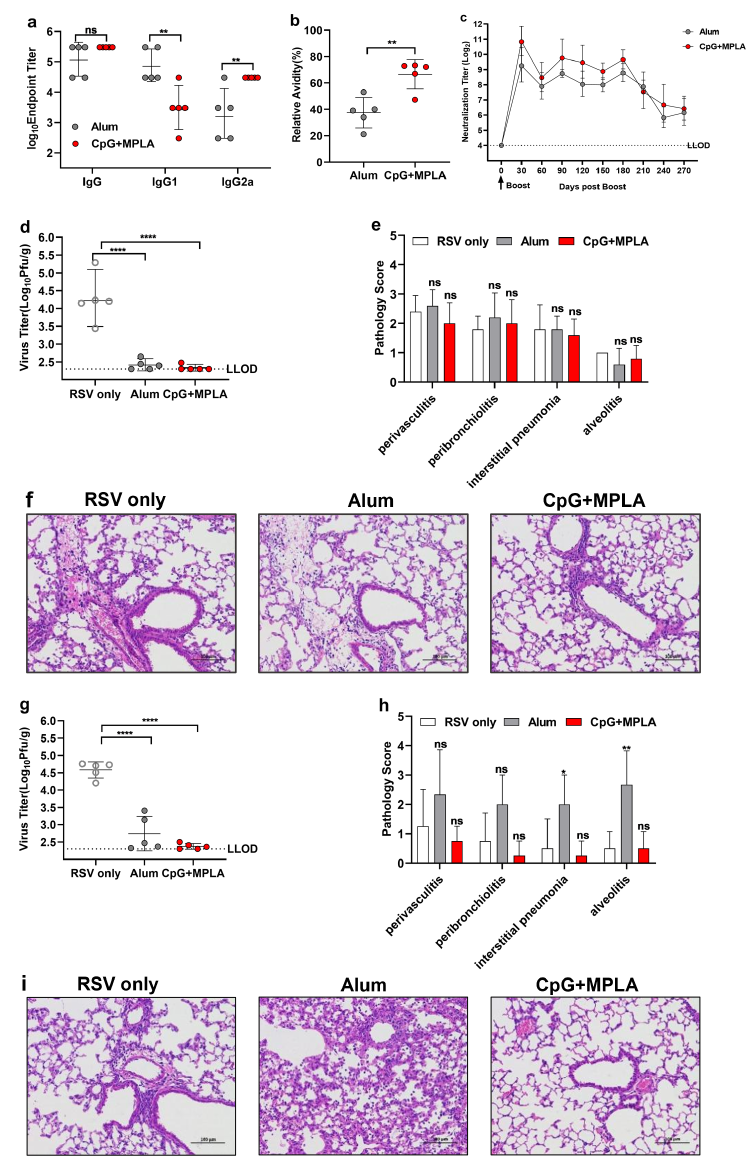
Figure 8. Opti-FI-RSV plus CpG + MPLA adjuvant protects mice from RSV challenge without inducing ERD when neutralizing antibody titers decrease. Female BALB/c mice (n = 5 per group) were injected intramuscularly with opti-FI-RSV combined with a Th2-biasing adjuvant (Alum) or a Th1-biasing adjuvant combination (CpG + MPLA) in a prime-boost regimen at week 0 and week 3. Animals were challenged with the RSV A2 strain intranasally at a titer of 2 × 10 6 PFU on day 49 and day 273. ( a , b ) Pre-F-specific IgG, isotype IgG1 and IgG2a serum antibody titers were determined at 2 weeks after boosting, and IgG avidity against pre-F after 7 M urea wash was determined at the same time point. ( c ) Serum neutralizing antibody titers were measured using RSV A2 with the indicated schedule. ( d , e ) Lung virus titers and histopathology scores were evaluated at day 5 after the first challenge ( d , e ) and second challenge ( g , h ). Representative H & E staining images are shown in ( f , i ). ( a – d , g ) The symbols indicate individual mice, the bars/lines indicate the geometric mean ± geometric SD, and the dotted lines indicate the lower limit of detection and the protective threshold. ( g , h ) The bars/lines indicate the mean ± SD. The data were analyzed by ( a , b ) t test, ( d , g ) one-way ANOVA followed by Tukey’s multiple comparisons post hoc test and ( e , h ) Kruskal-Wallis test (nonparametric) to analyze the differences between vaccination groups. The adjusted p values are shown by asterisks (ns = not significant; * p < 0.05; ** p < 0.01; **** p <